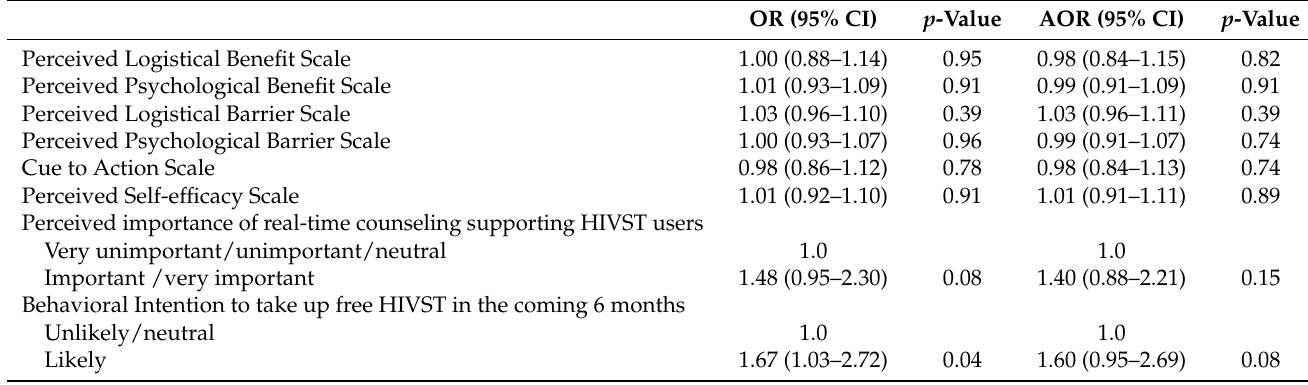
Table 4. Factors predicting the uptake of HIVST-online ( n = 350).